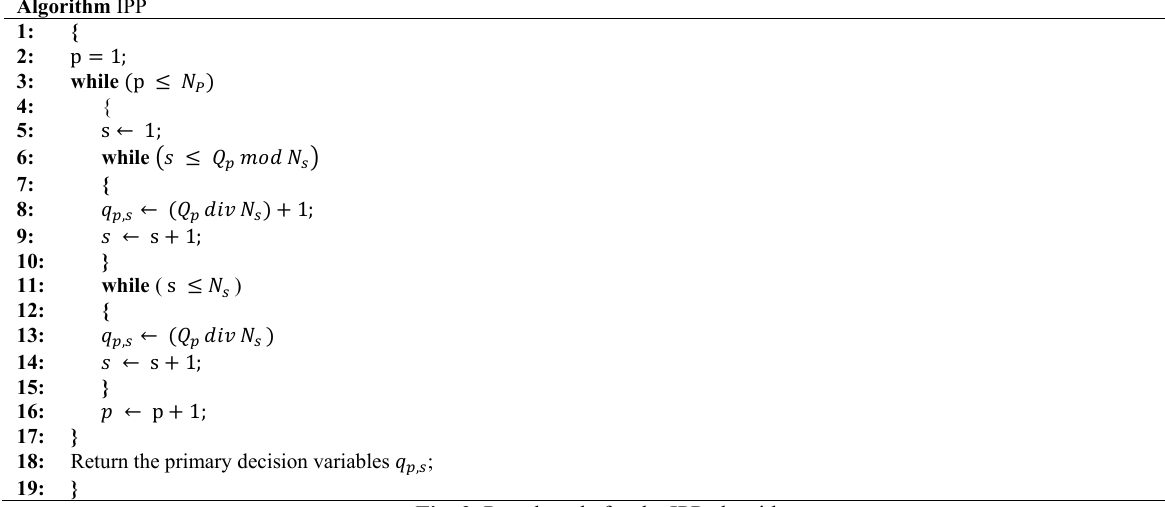
Fig. 3. Pseudocode for the IPP algorithm